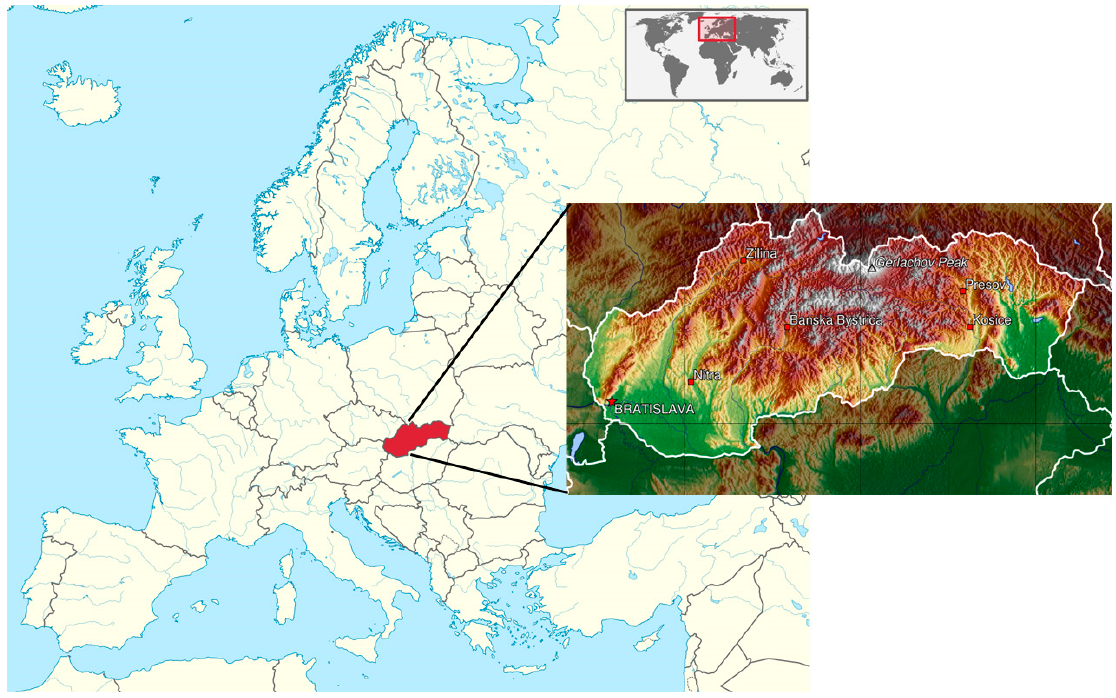
Figure 2. Location of Slovakia and the topography of Slovakia .